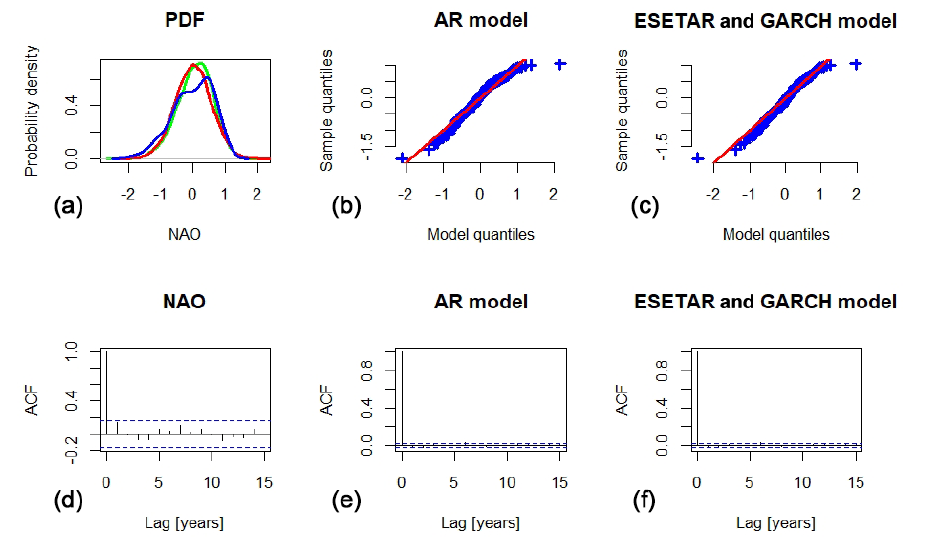
Figure 13. Simulations of winter means of the NAO. The plots are identical to Fig. 11, but with weekly means replaced by winter